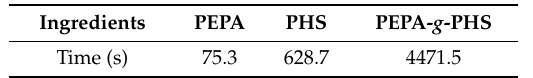
Figure A3. The maximum strength and elongation at break in uniaxial tension. Appendix C The 𝑉𝑉 𝑓𝑓𝑖𝑖 and 𝜎𝜎 𝑓𝑓𝑖𝑖′ denote the volume fraction and modified strength of a new joined filler, respectively. As well as 𝜎𝜎� 𝑖𝑖 is the strength of the generated composite (the new composite) while 𝜎𝜎� 𝑖𝑖−1 is of the old one. According to Equation (12), we obtain